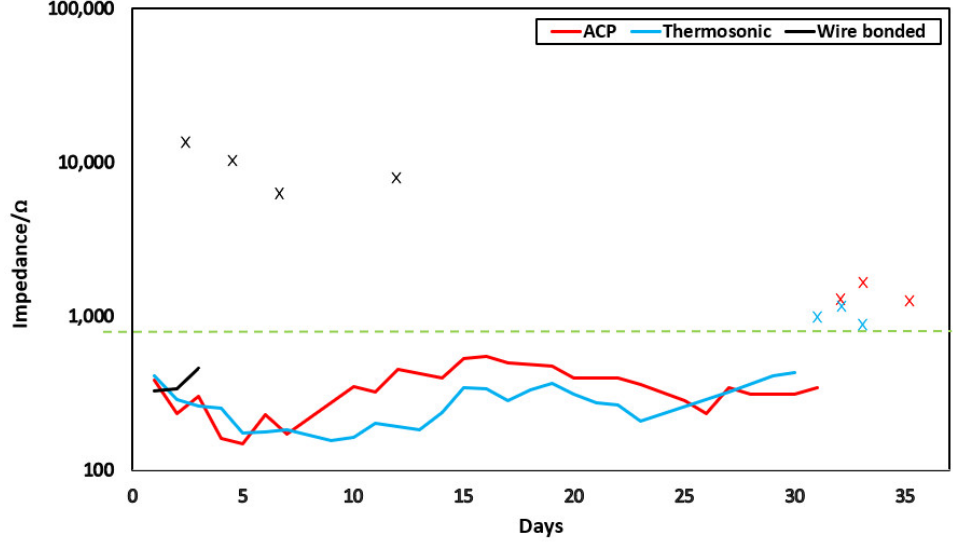
Figure 8. Long-term impedance variation of thinned IDE sensors far a span of days at 1 MHz, where (X) defines the failed samples.